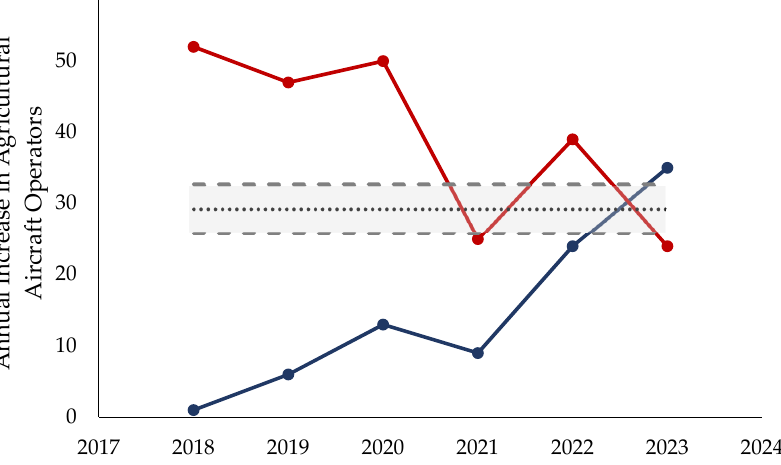
Figure 3. The annual increase in manned (red) and unmanned (blue) agricultural aircraft operators and the average annual increase in manned operators since 1967, with a 95% confidence interval.